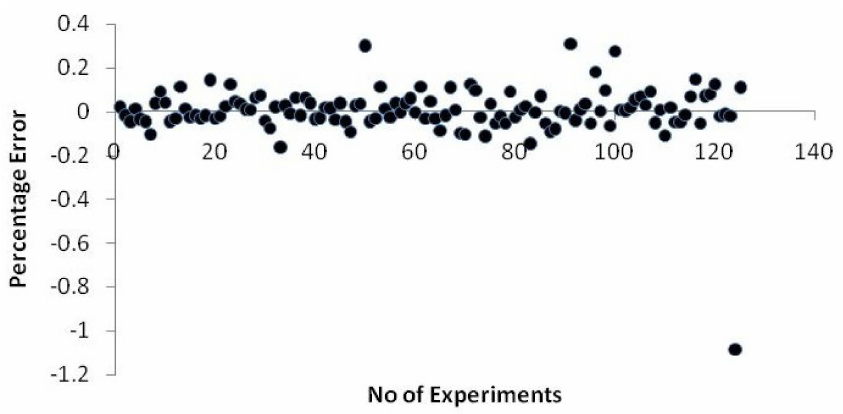
Figure 21. Error graph of network 4-8-3 for angular distortion with time gap between four passes. Figure 22 depicted the network’s performance graph. The training was carried out for 1000 iterations, with an MSE of 6.1041 × 10 − 8 observed at the 1000th epoch, as shown in the figure.